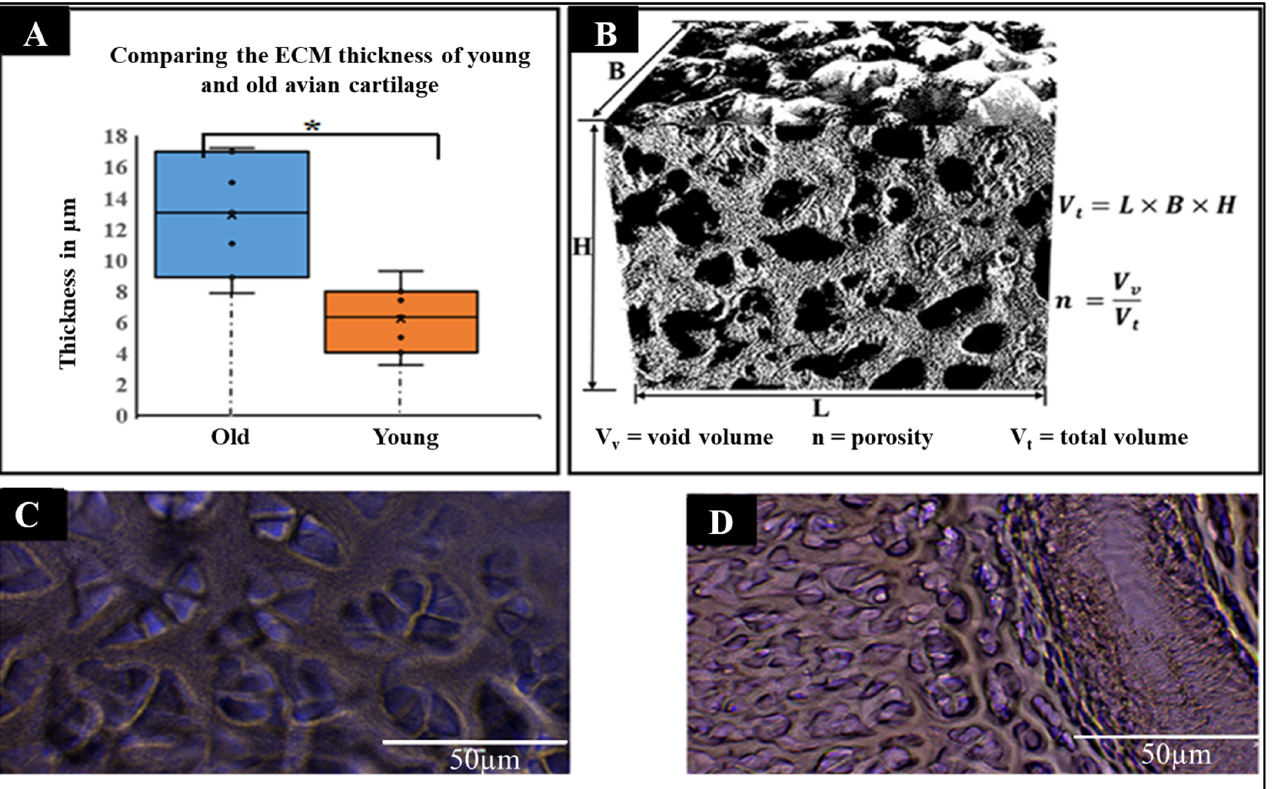
Figure 3. Dimensional analysis of Scaffold’s ECM and pores. ( A ) Quantitative measurements of ECM thickness of young and old avian articular decellularized cartilage. ( B ) 3D rendition of the decellularized scaffold, depicting the pore distribution and nano-grooves found on the ECM. ( C ) Stained scaffold image showing the pores of decellularized old avian articular cartilage. ( D ) Stained scaffold image showing the pores of decellularized young avian articular cartilage. Data are shown as mean ±SEM from 16 independent avian articular cartilages (8 young avian articular cartilages and 8 old avian articular cartilages. * p -value = 0.007. Scale Bar = 50 µm.